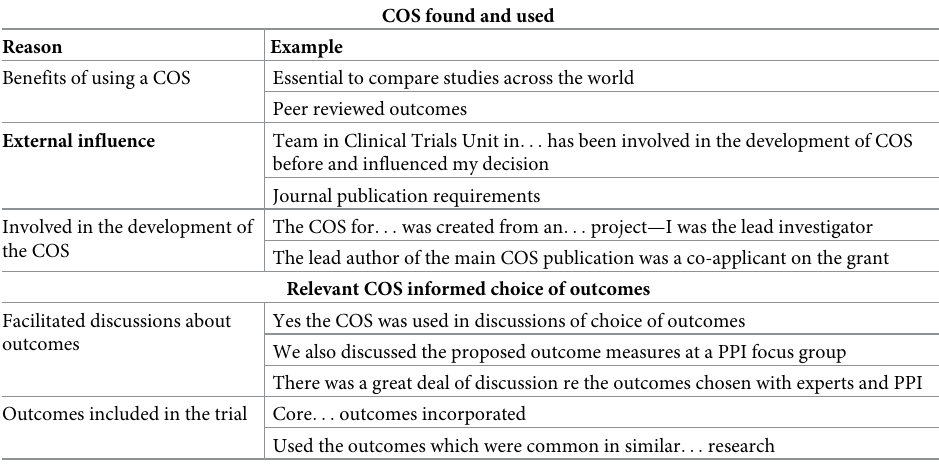
Table 3. Examples of reasons given by applicants for their decision to use a